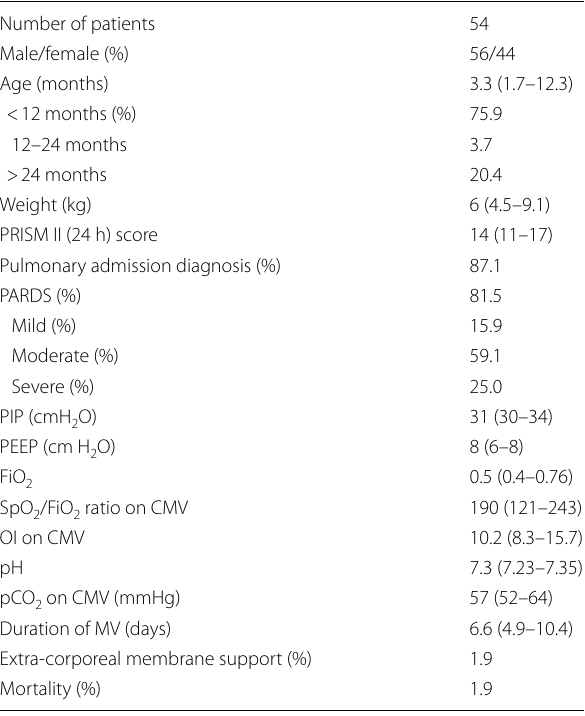
Table 1 Patient